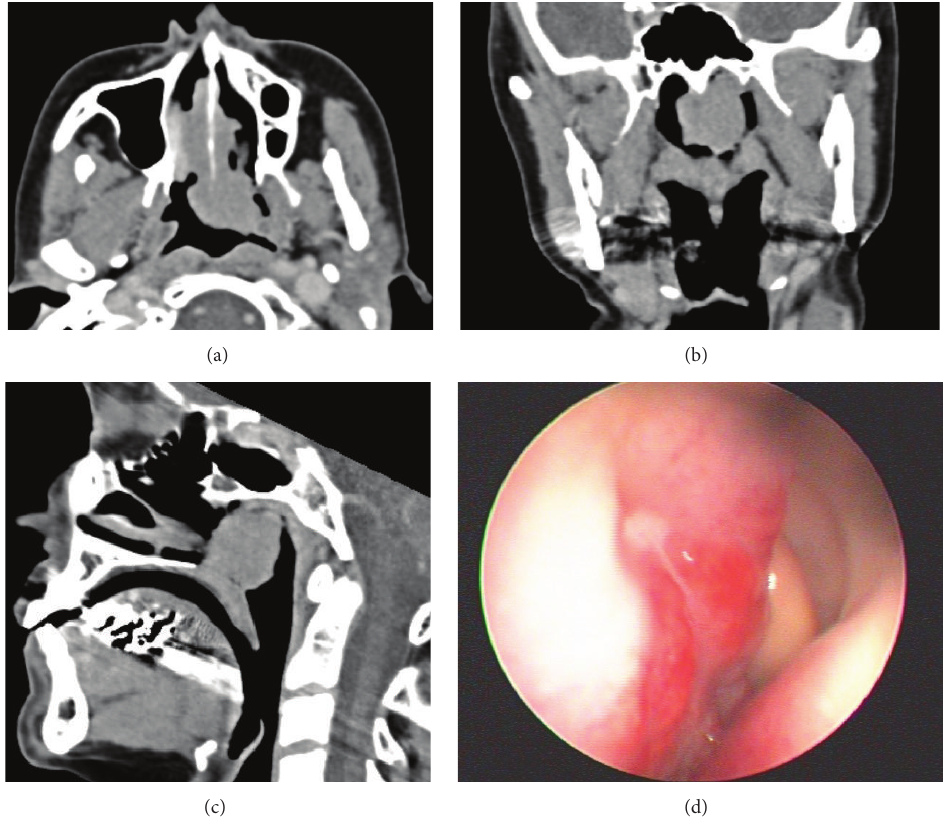
Figure 2: Imaging showing nasal septal lesion. CT images: (a) axial, (b) coronal, and (c) sagittal view. Endoscopic view left side: (d) lesion arising from the posterior part of the left nasal